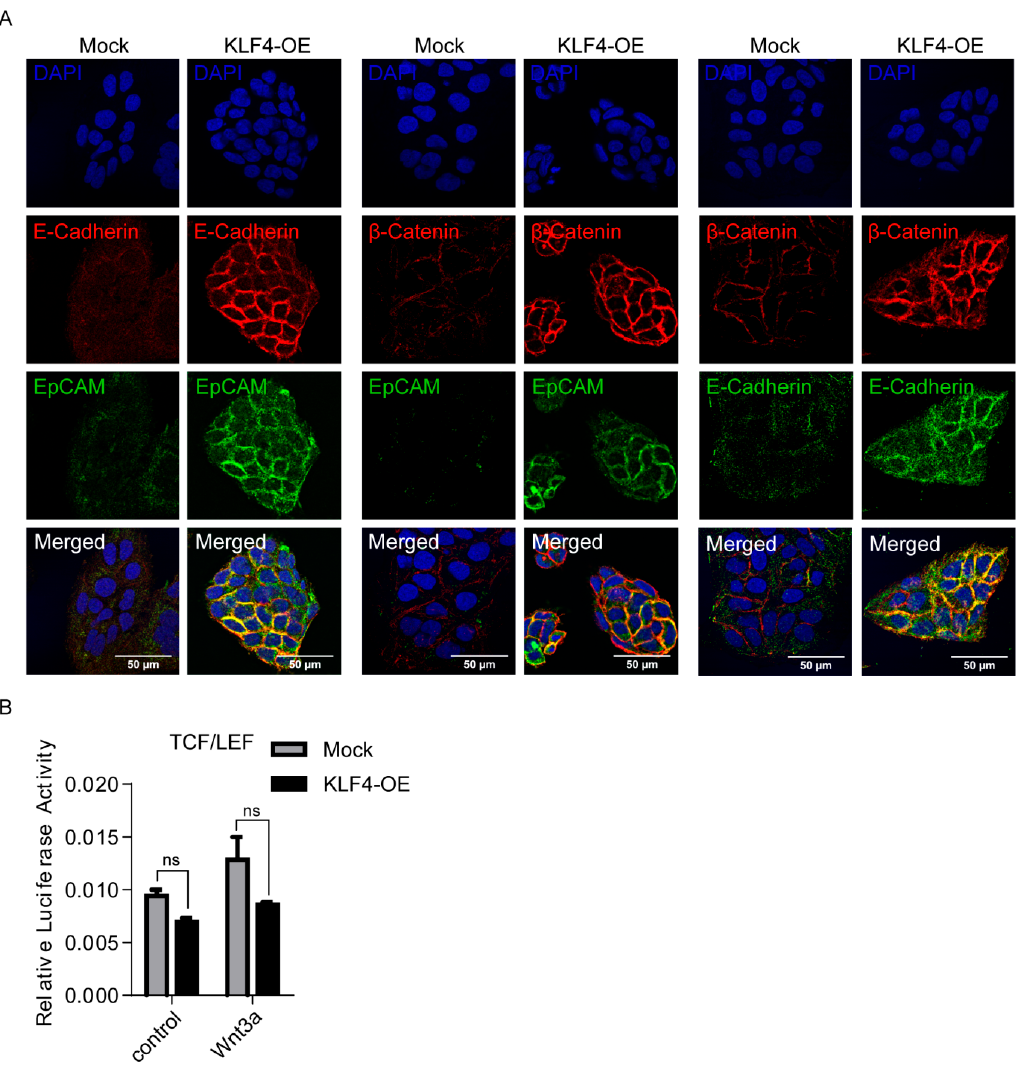
Figure 3. KLF4 overexpression increases EpCAM, E-CAD and β -CAT cell membrane expressions in non-stem cells. ( A ) Representative confocal images of KLF4-overexpressing and mock cells for EpCAM, β -catenin and E-cadherin expressions are shown. Nuclei were co-stained with DAPI. ( B ) SuperTOPFlash reporter and Renilla luciferase plasmids were co-transfected into KLF4-overexpressing and mock cells. Luciferase activity was measured with or without the WNT3a (80 ug / mL) recombinant protein. Data represent the average of at least three independent experiments. Error bars indicate SD.